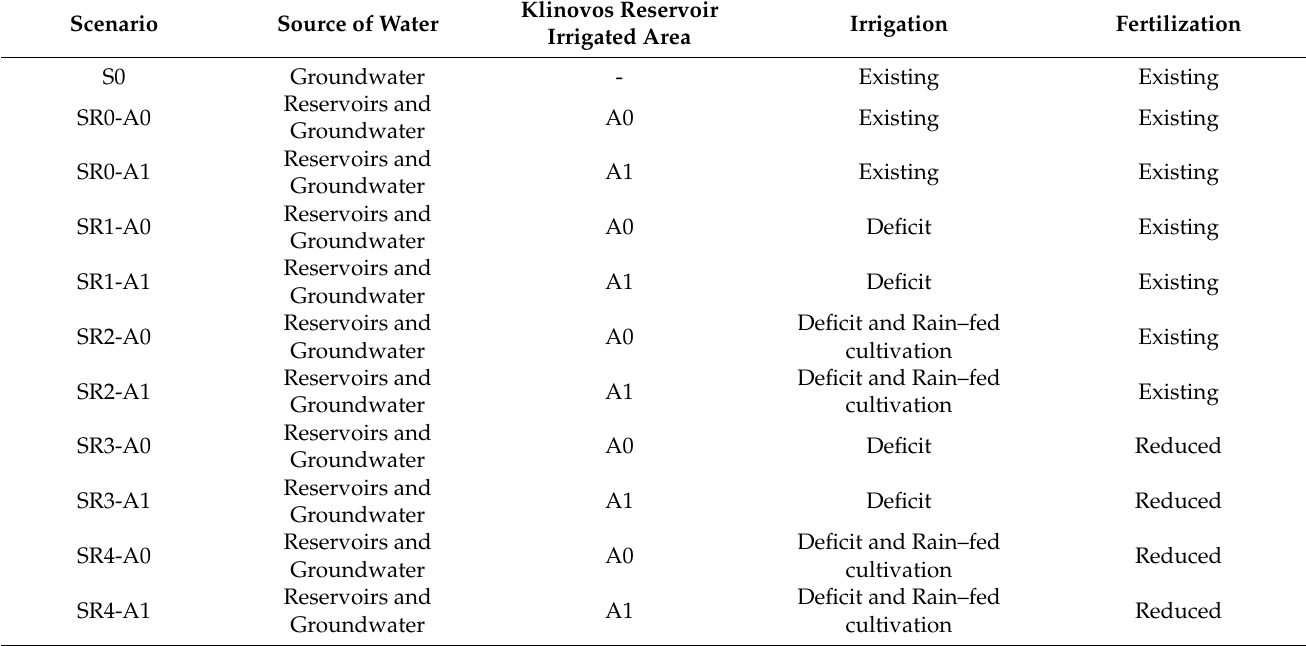
Table 3. Summary of the agronomic and water resources management